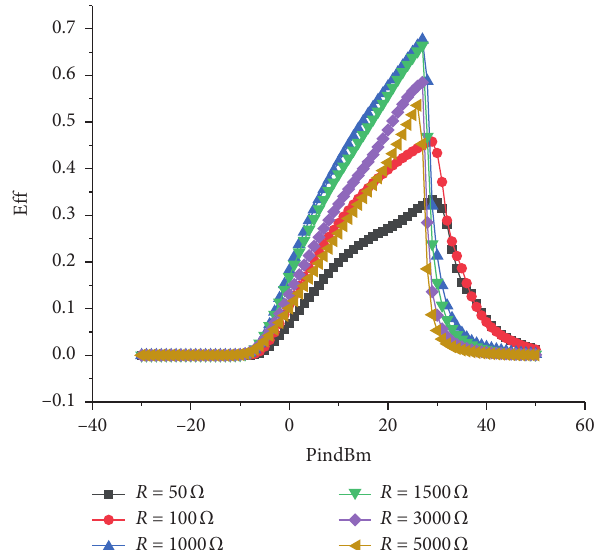
Figure 13: Conversion efficiency of resistance load R � 50 Ω , 100 Ω , 1000 Ω , 1500 Ω , 3000 Ω , and 5000 Ω in the rectifier circuit.